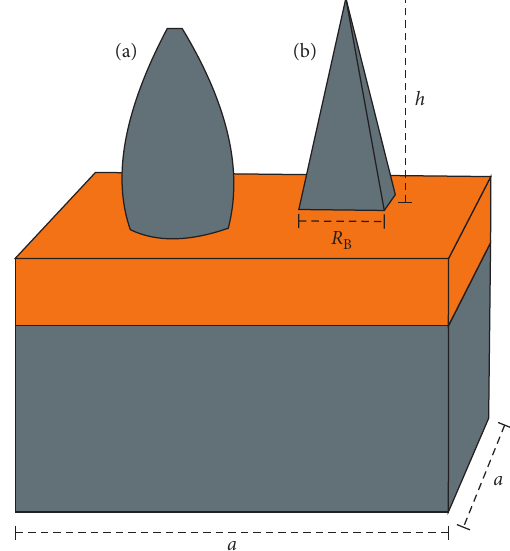
Figure 11: Arrangement of nanoantennas: (a) convex truncated cone (CNV) and (b) pyramidal